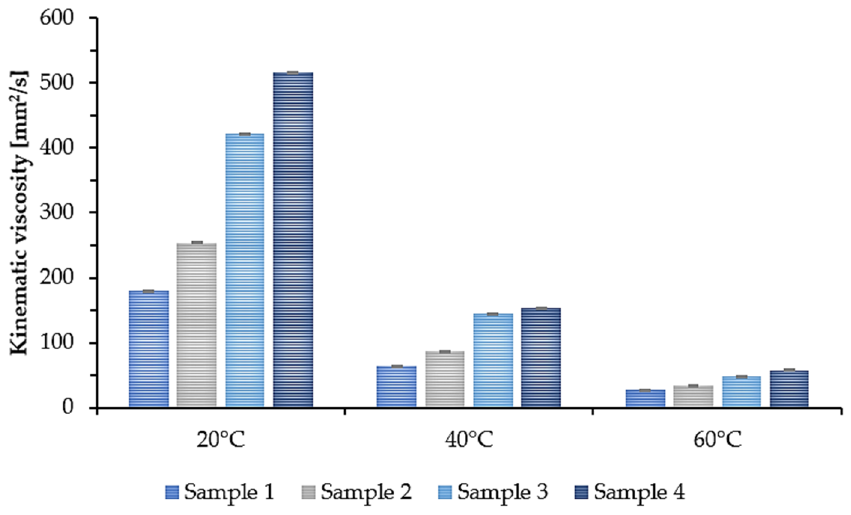
Figure 6. Kinematic viscosity of epoxidized mixed esters (Samples 1–4) at 20, 40, and 60 °C.